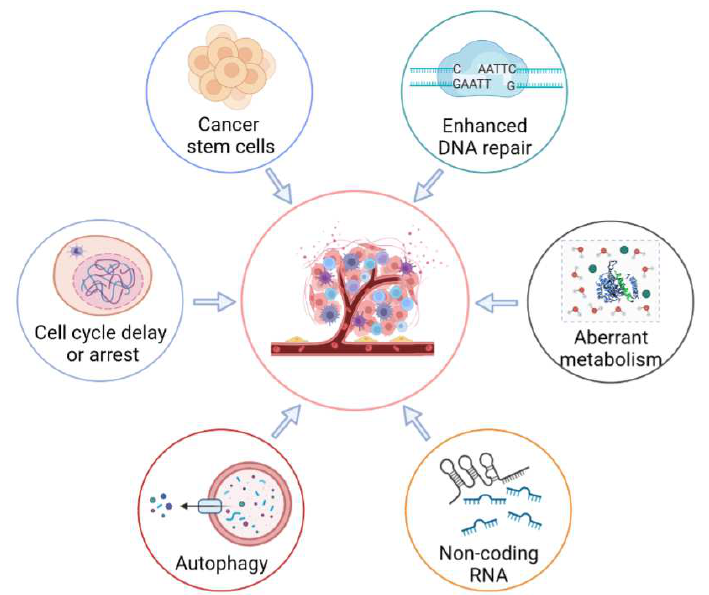
Figure 2. Molecular mechanisms of radioresistance mediated by tumor cells. Radioresistance of tu- mor cells is a major barrier to successful cancer treatment. In order to evade cell death, tumor